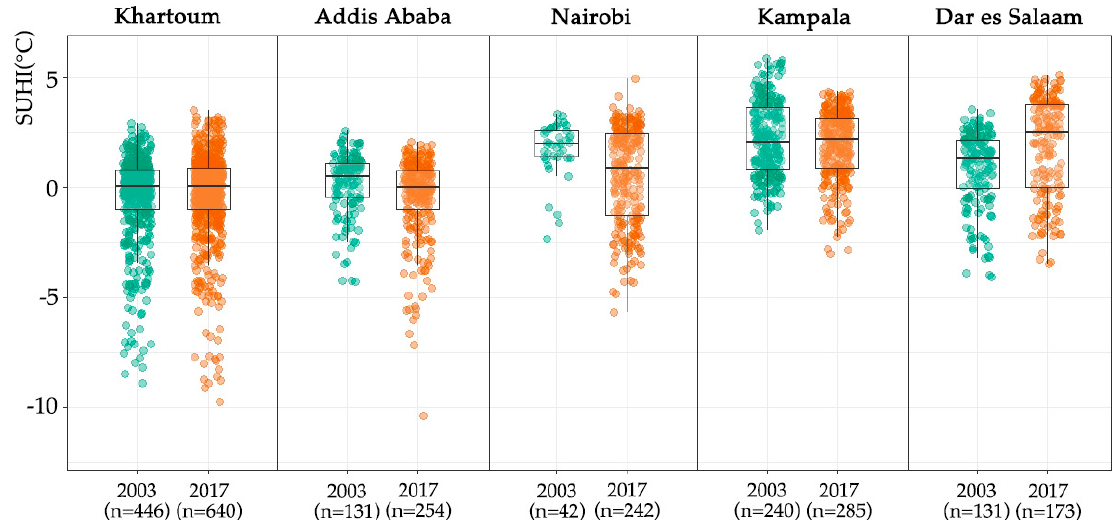
Figure 4. Daytime SUHI value distributions for each city in 2003 and 2017. The boxplots show the distribution of daytime